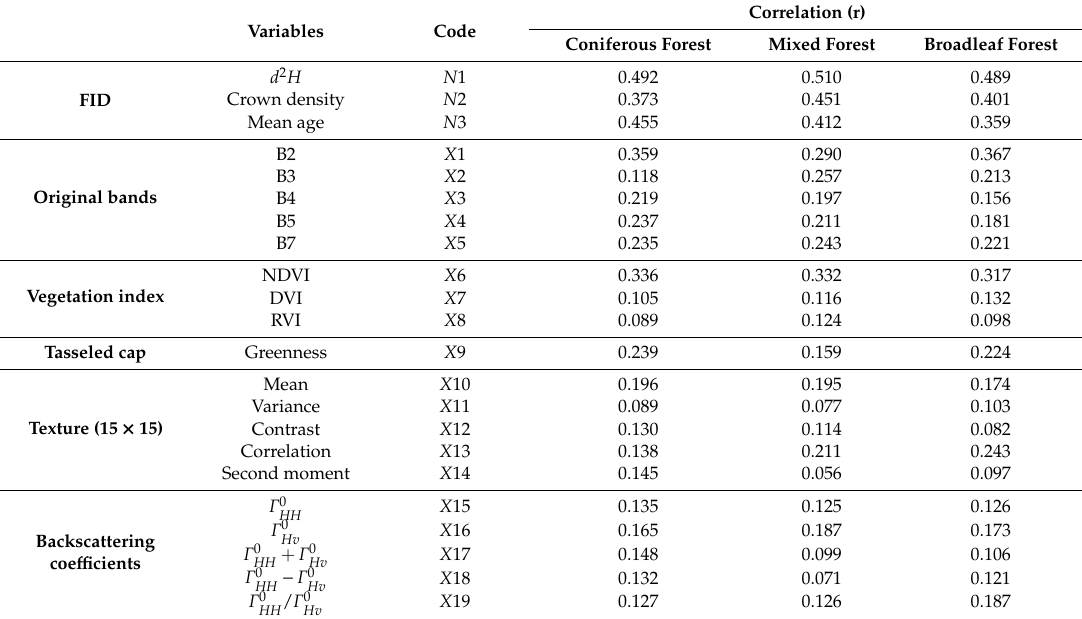
Table 3. Coe ffi cients of correlation between forest biomass and variables.